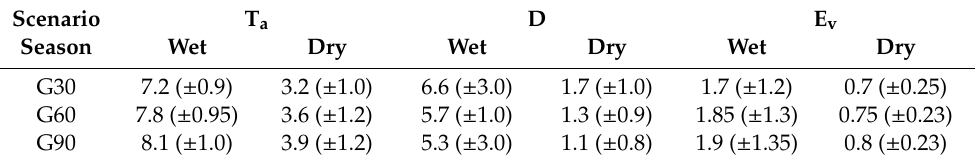
Table 2. Monthly averages (and, between brackets, standard deviations) of actual transpiration (Ta), drainage (D), and evaporation (E v ), all in cm month -1 , for G30, G60, and G90 scenarios in the wet